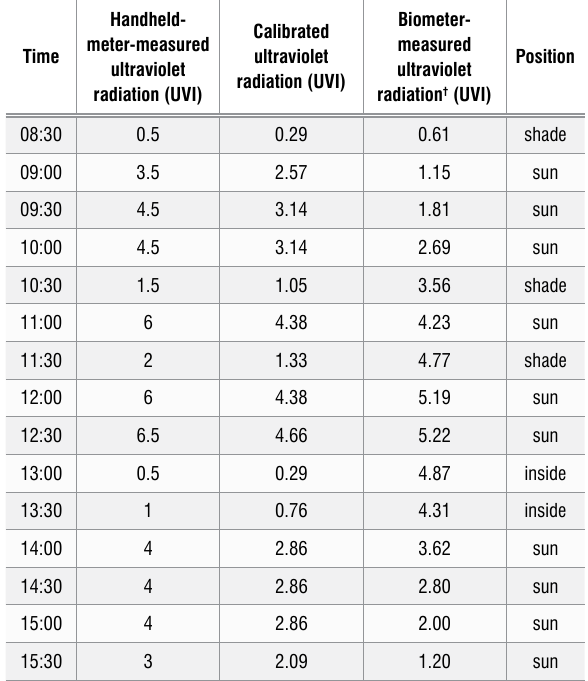
Table 2: Ultraviolet radiation values and position of outdoor worker on Day 1 of fieldwork Handheld- meter-measured Time ultraviolet radiation (UVI)